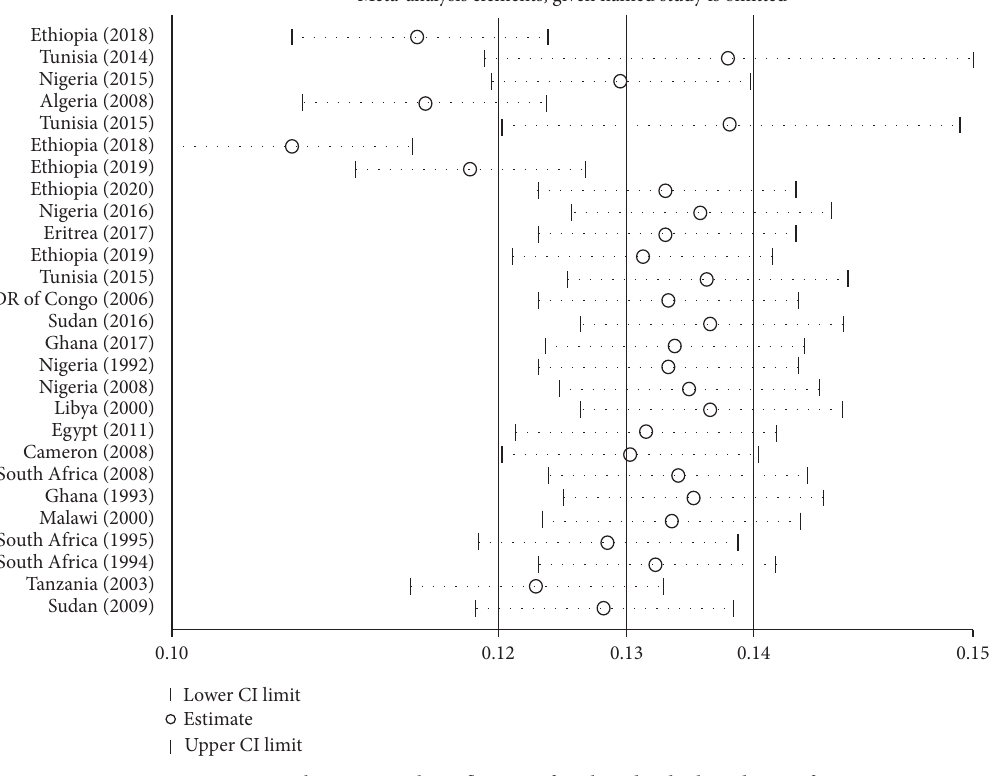
Figure 4: Sensitivity analysis to see the influence of each individual study in Africa, 2020.